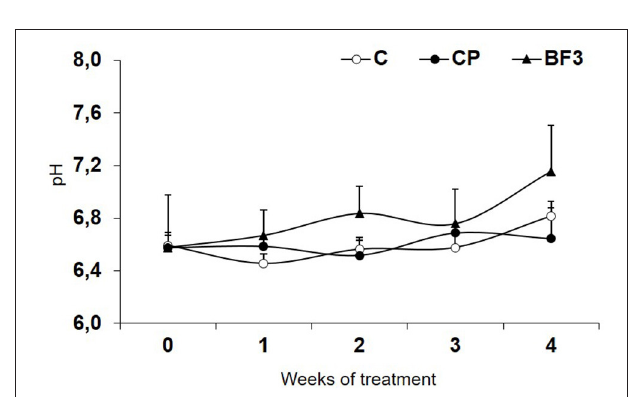
FIGURE 2 | Evolution of soil pH during the biofumigation field experiment. Control non-amended without plastic cover (C); control non-amended